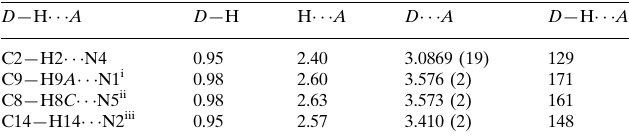
Hydrogen-bond geometry (A˚ , (cid:1)